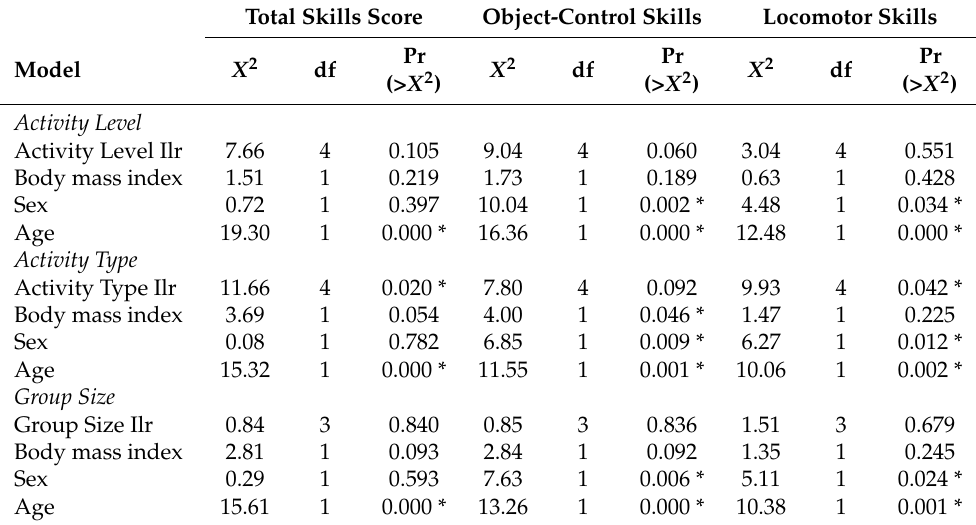
Table 2. Isometric log-ratio regression models examining play behavior composites and